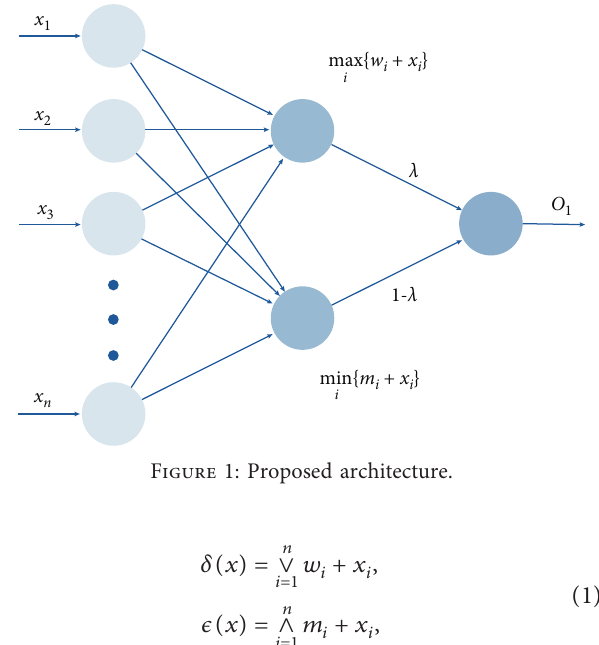
Figure 1: Proposed